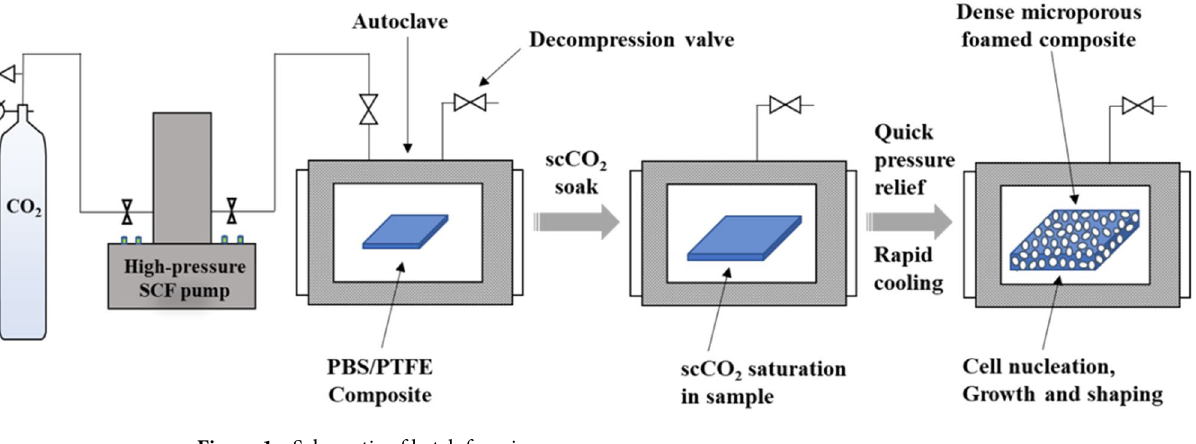
Figure 1. Schematic of batch